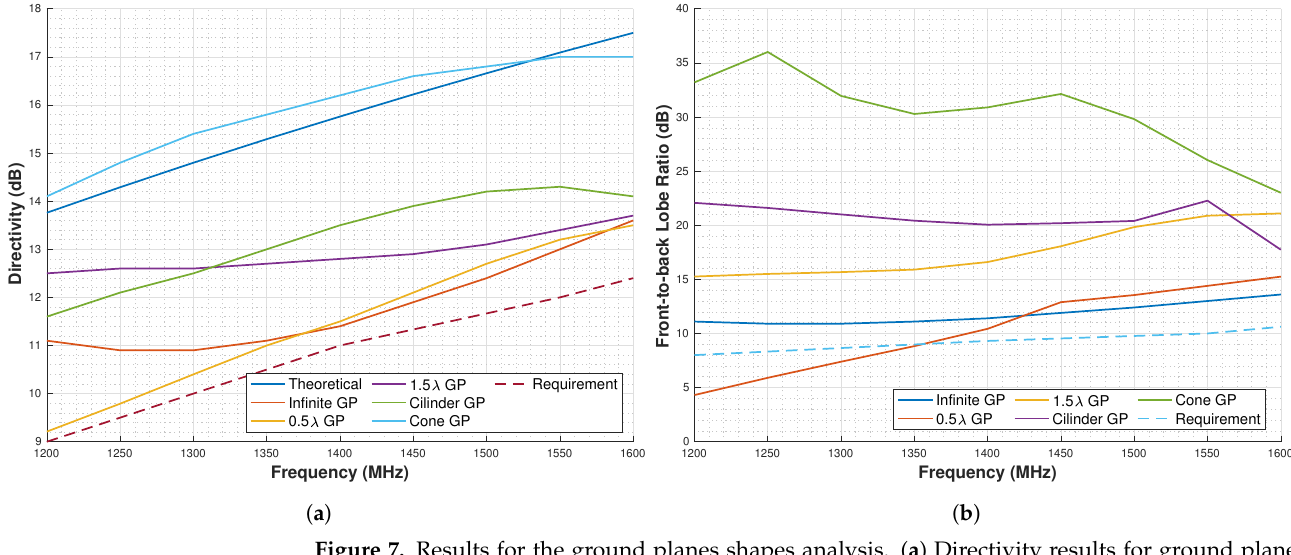
Figure 7. Results for the ground planes shapes analysis. ( a ) Directivity results for ground plane shapes analyzed. ( b ) Front-to-back lobe ratio results for ground plane shapes